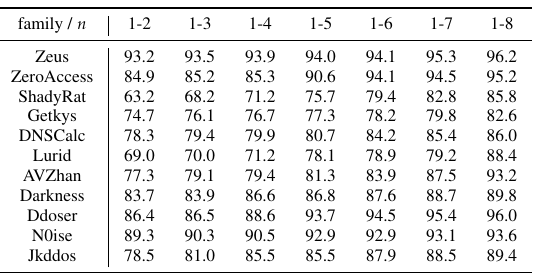
Table 5. Accuracy of classifying various families for different values of n when calculating the n -gram combined features.